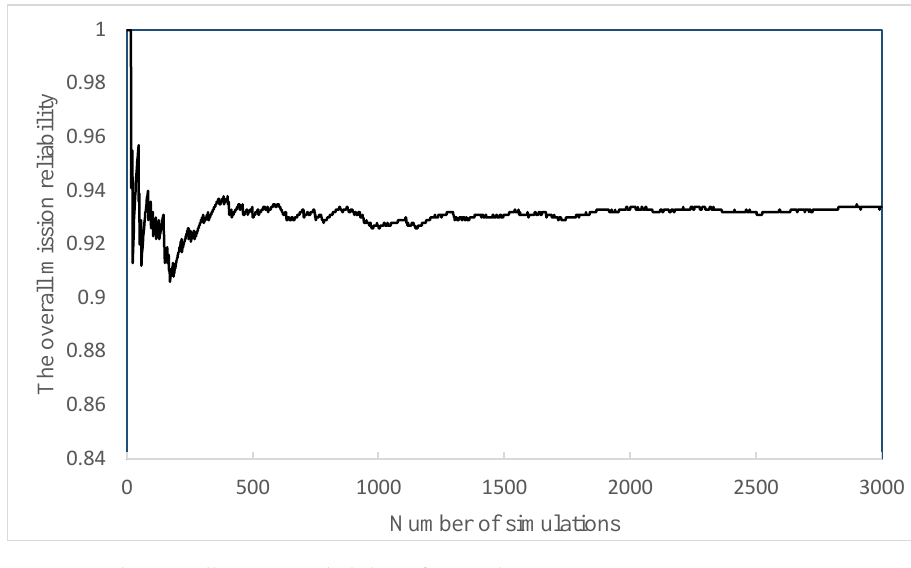
Figure 14. The overall mission reliability of a warship mission.